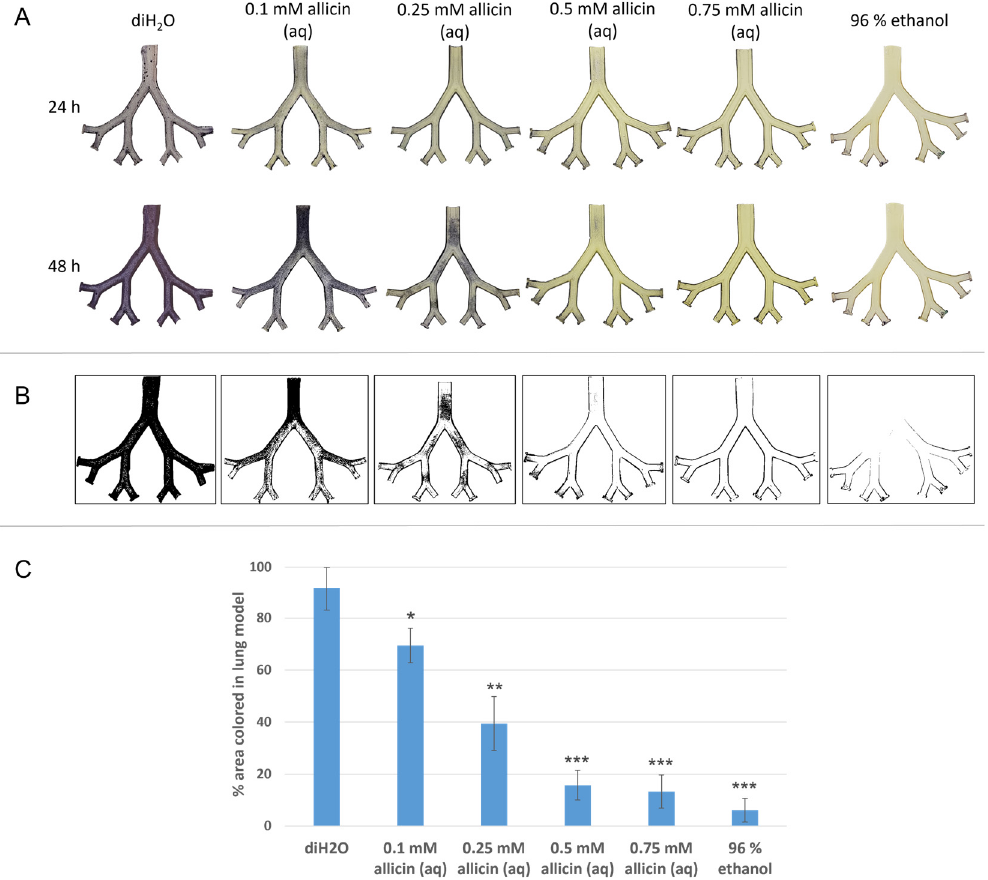
Figure 4. Concentration-dependent inhibition of spore germination after aerosol treatment of the lung model with aqueous allicin solution. A volume of 20 mL of 2% ( w / v ) PDA medium (50 °C) mixed with spore suspension of Paecilomyces formosus (10 6 spores per mL) was used to coat each lung model half-shell. The supply air was adjusted to 6 L per min. The model was treated with aqueous allicin solution in the lung simulation apparatus for 20 min and subsequently incubated at 37 °C. ( A ) After 24 h and 48 h of incubation, fungal growth was detected by staining with MTT. The lower half of the experiment model is shown. ( B ) Binary images of the 48 h incubated model halves. ( C ) n = 3, error bars show standard deviation. Significant differences to the water control in a Student’s t-test are marked by asterisks ( p < 0.05 = *; p < 0.01 = **; p < 0.001 = ***).